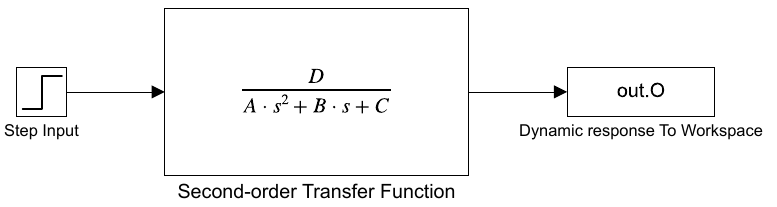
Figure 7. Simulation for obtaining the step response of a second-order transfer function for all